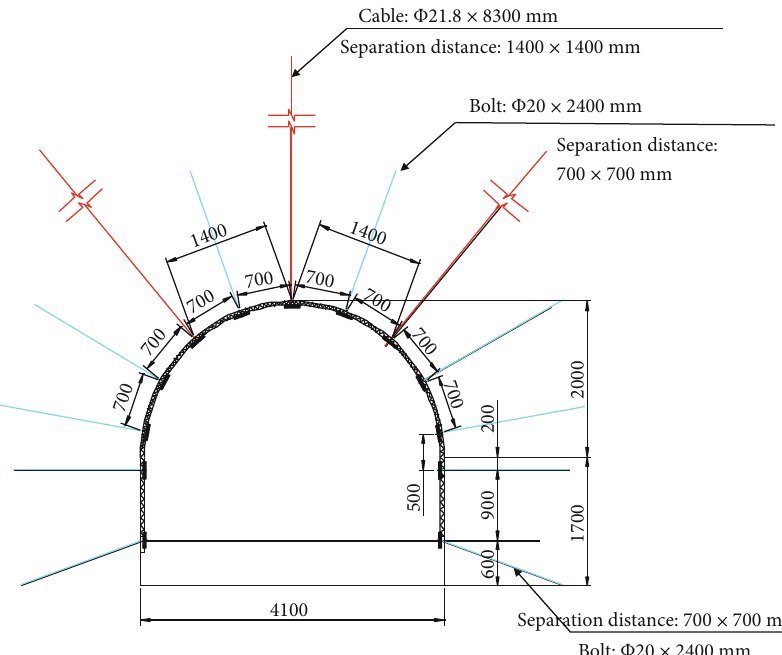
Figure 17: Support scheme within 5m behind the docking position of ducking